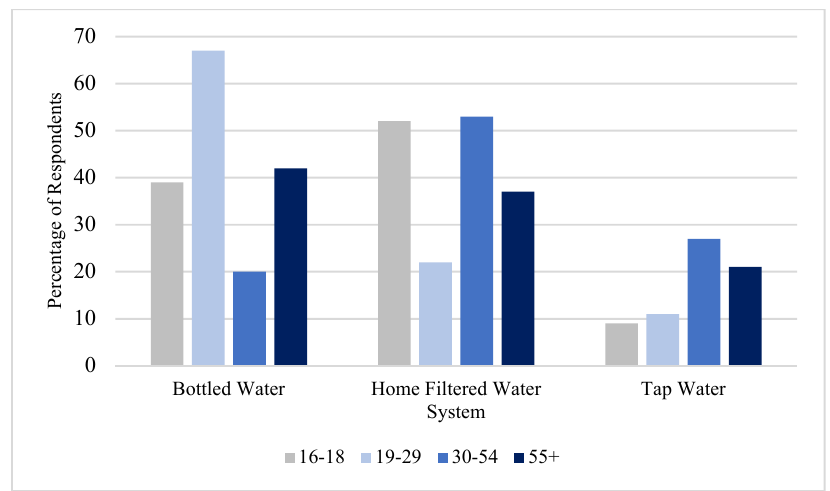
Figure 1. Main Sources of Drinking Water.